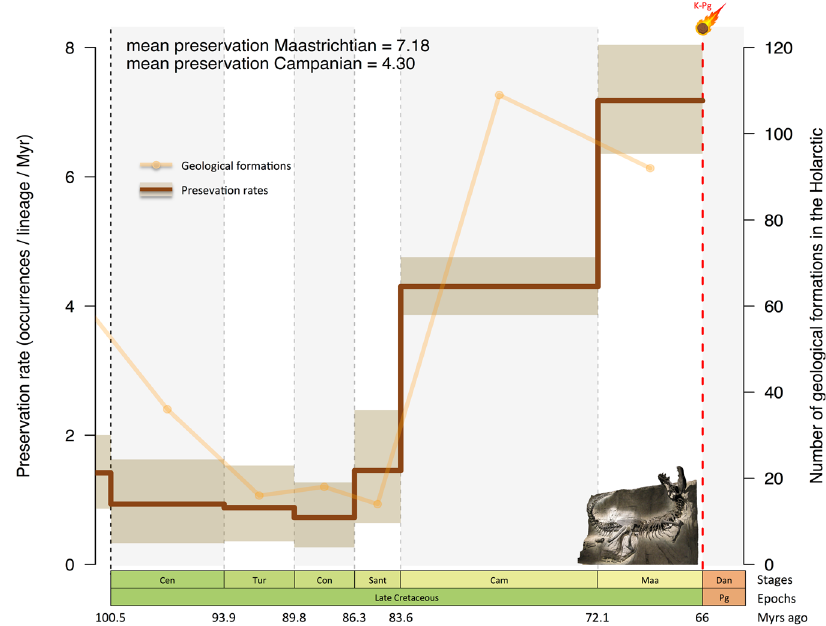
Fig. 2 Temporal variations of the preservation rates of Late Cretaceous dinosaurs. The Bayesian inferences in PyRate allow estimating the mean preservation rates (i.e. number of occurrences per species per Myr) and the variations though time. Solid lines indicate mean posterior rates and shaded areas show 95% CI. Our estimate shows that the mean preservation increased through time and toward the Cretaceous – Paleogene boundary culminating in the Maastrichtian with more than seven occurrences per species per Myr. Superimposed are the number of Late Cretaceous geological formations from the Paleobiology Database. Abbreviations as in Fig. 1. Picture of the ‘ Black Beauty ’ tyrannosaur made by Fabien Condamine at the Royal Tyrrell Museum of Palaeontology (Drumheller, Canada). Asteroid icon made by Fabien